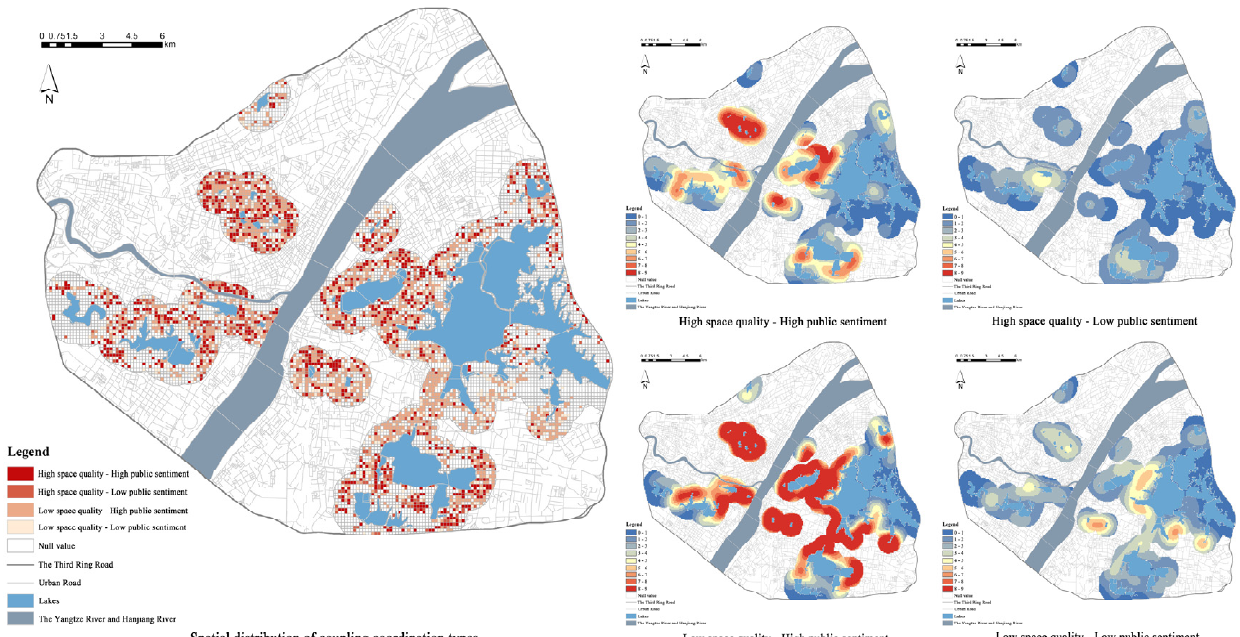
Figure 14. Spatial distribution of coupling coordination type between spatial quality and public sentiment (see Figure A3 in Appendix A).